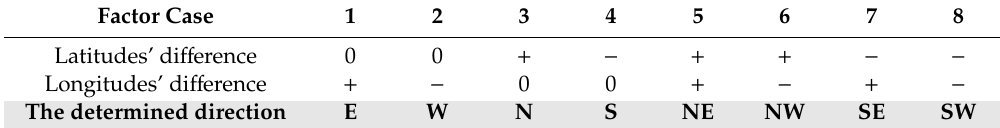
Table 1. Factors and cases for determining the exact cardinal direction.